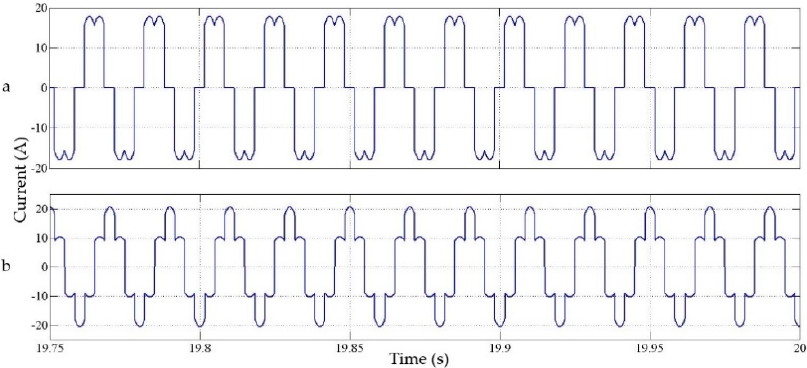
Figure 12. Transformed currents ( a ) i α ; ( b ) i β .